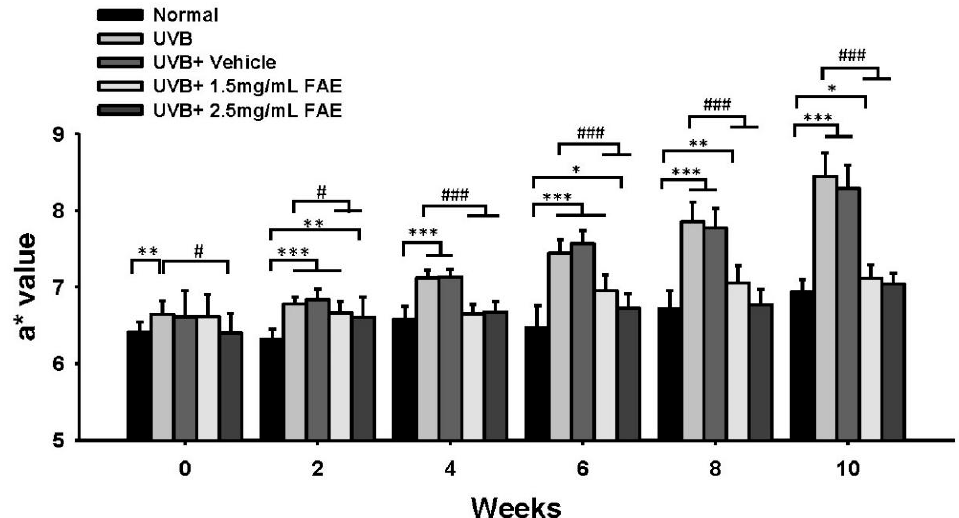
Figure 7. Quantification a* value of dorsal skin upon Ficus awkeotsang Makino extract (FAE) treatment at different concentrations following UVB irradiation on BALB/c nude mice from 0 to 10 weeks. Statistically significant differences from the control were observed with * p < 0.05, ** p < 0.01, *** p < 0.001; statistically significant difference from UVB-exposure group was observed with # p < 0.05, ### p < 0.001 statistical significance was determined using Tukey’s HSD test. n = 3; all error bars represent the standard deviation of the mean.